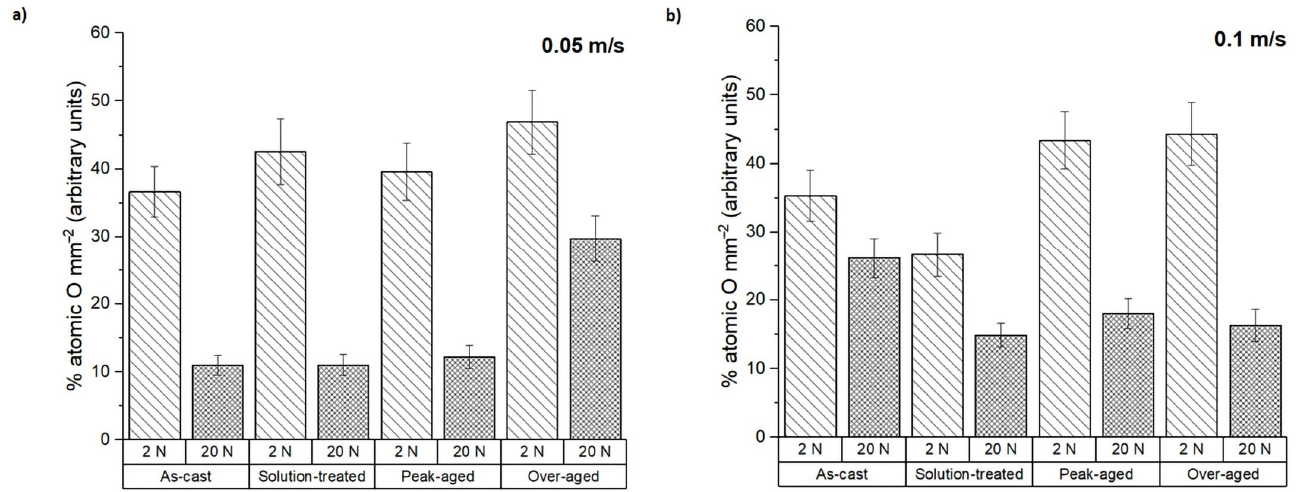
Figure 12. SEM micrograph and EDS analysis of the wear debris found in the over-aged ZX30 alloy samples at 20 N and 0.1 m s − 1 . A and B correspond to zones with different composition: A is richer in Al, and B is richer in O.